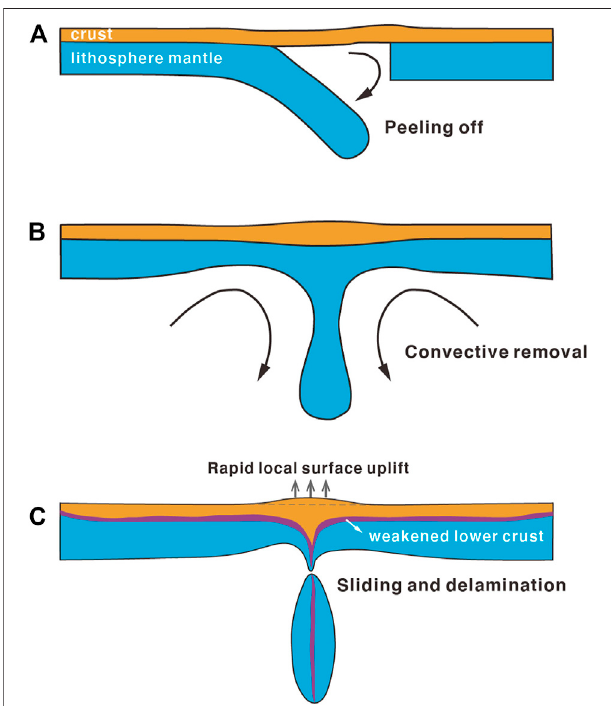
FIGURE 9 | Schematic illustration of three types of lithosphere mantle removalduringcollisionalorogeny. (A) Conventionaldelaminationmodel(Bird, 1979). (B) Convectiveremoval via Rayleigh-Taylorinstability(Housemanet al., 1981). (C) Weakened lower crust-assisted